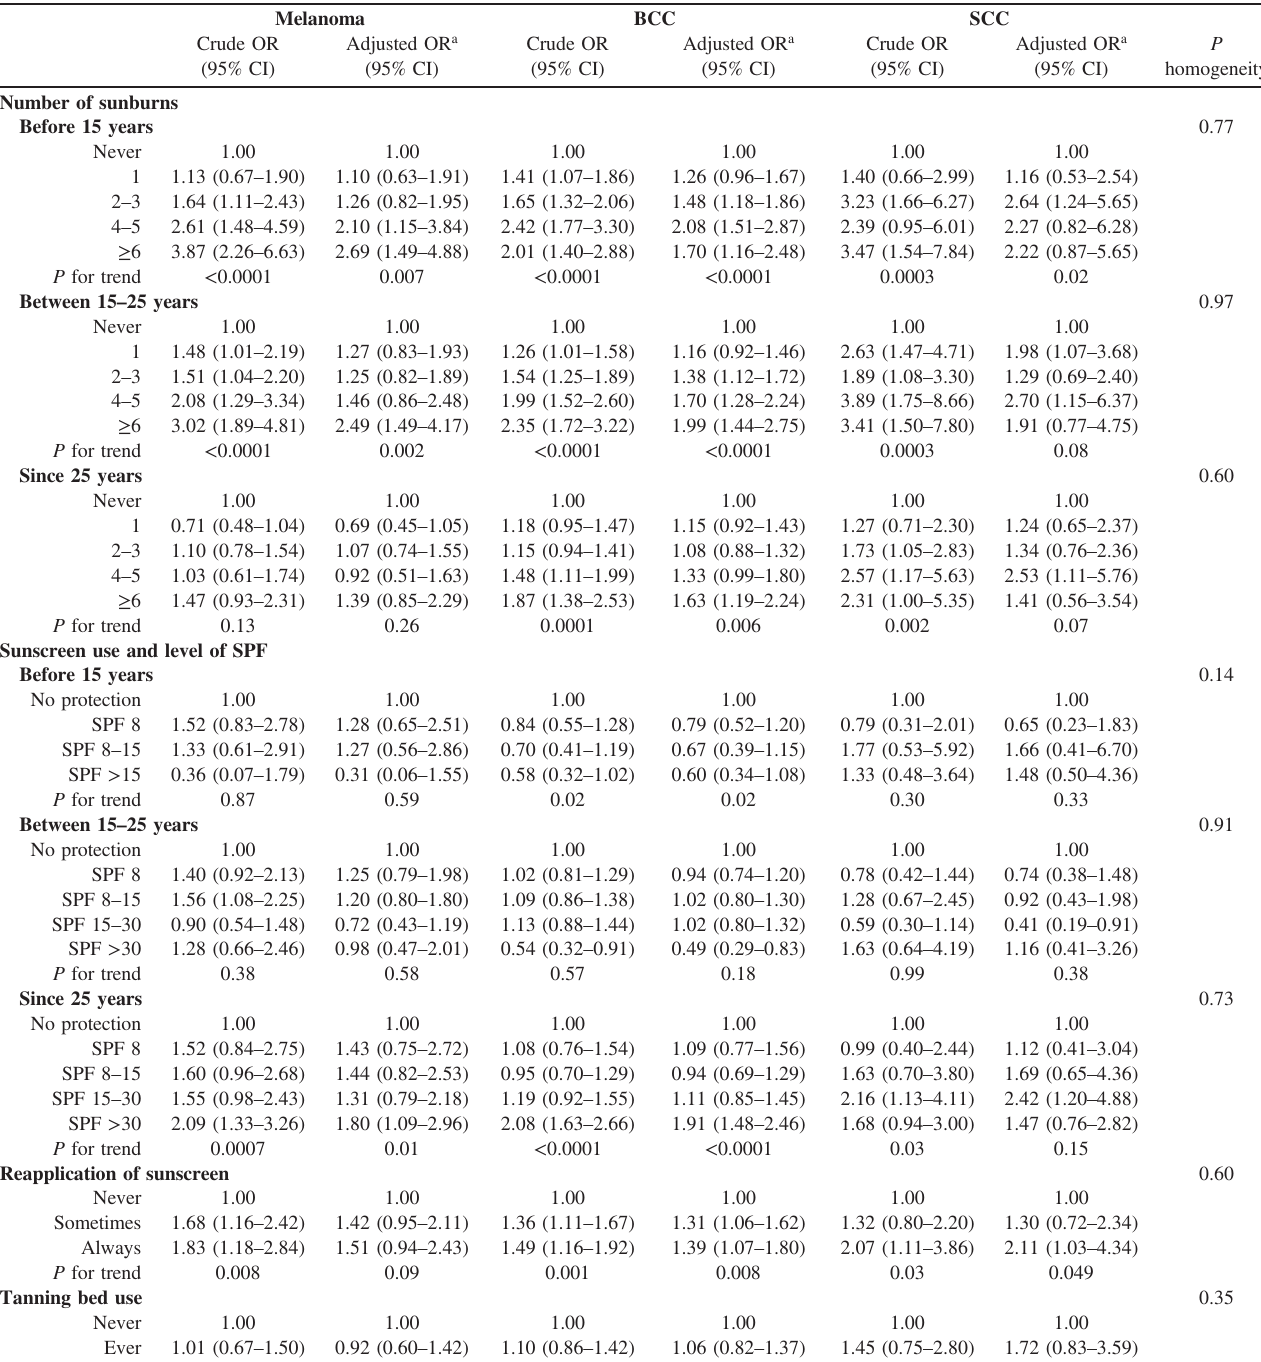
Table 1. Crude and adjusted ORs for risks of melanoma, BCC and SCC associated with number of sunburns, sunscreen use, and use of tanning beds ( n =